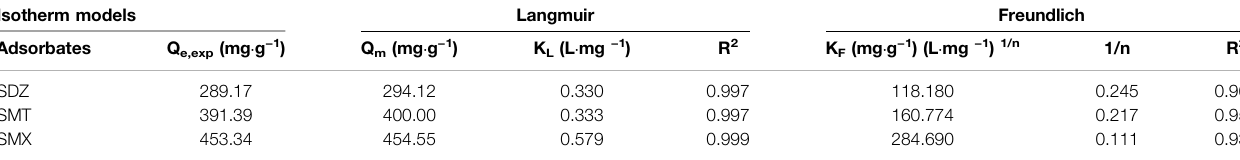
TABLE 3 | Adsorption isotherm constants for SAs adsorption onto 50MBC-KOH 2.5 at 298 K. Isotherm